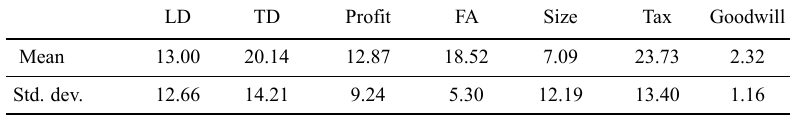
Panel A. Mean and standard